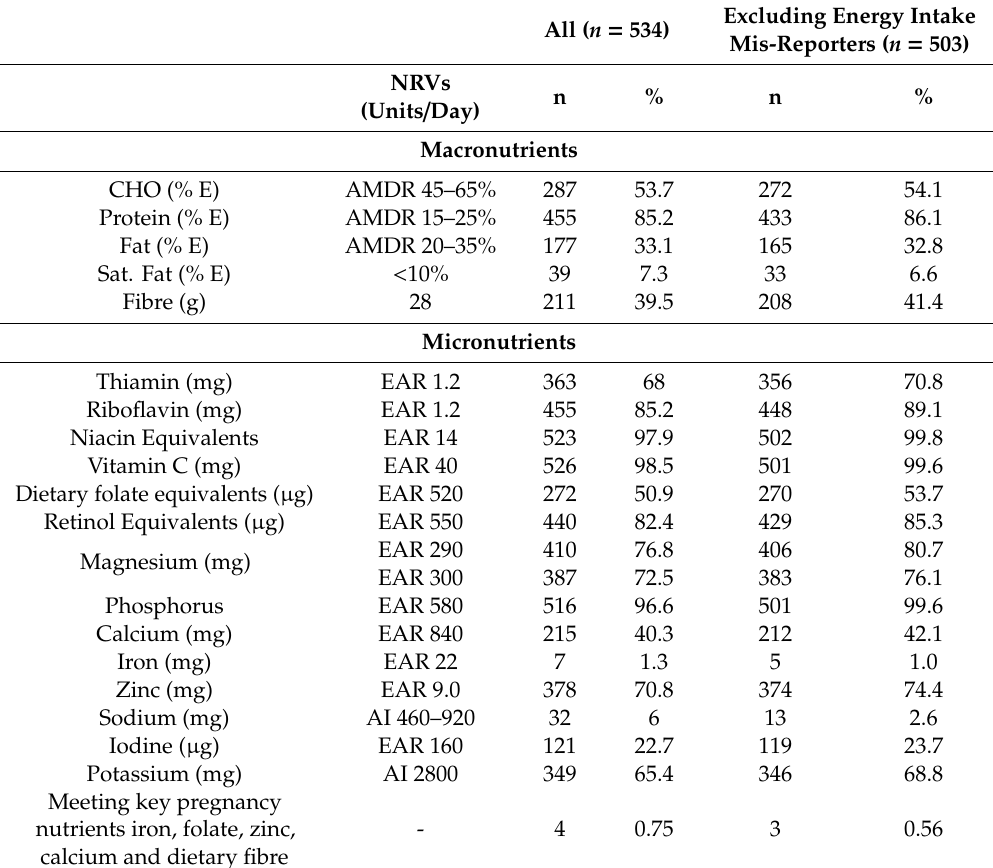
Table 4. Estimated proportion of pregnant women whose intakes met Nutrient Reference Values